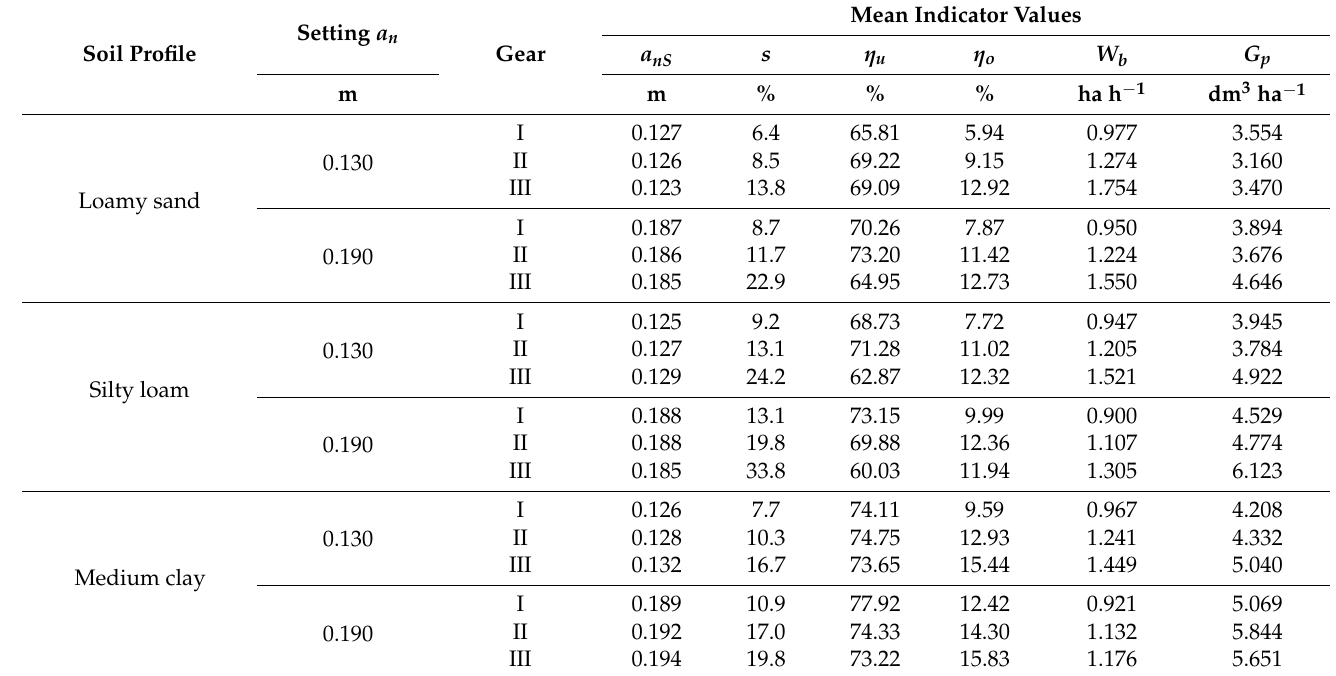
Table 2. Mean values of performance indicators of the unit with enabled force control of the implement linkage system for two cutting depth settings, three gears, and three soil profiles. Mean Indicator Values Setting a n Gear Soil Profile